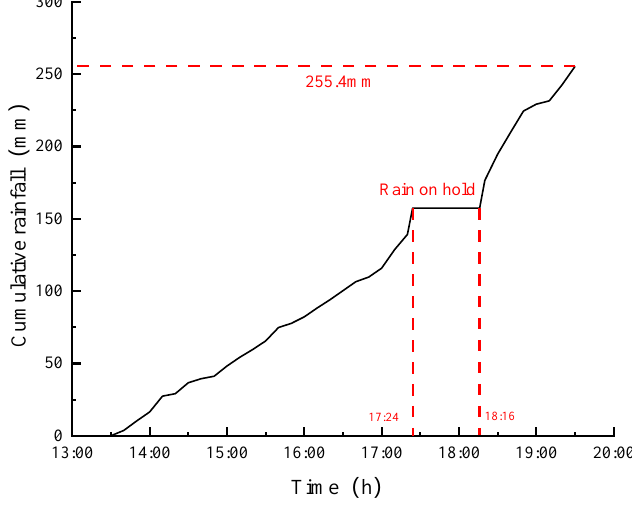
Figure 4. Rainfall vs. time